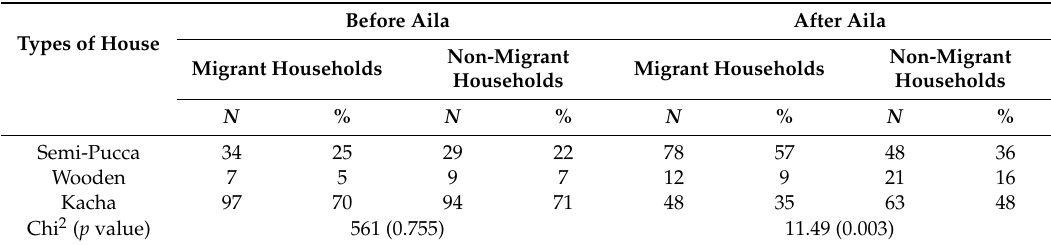
Table 12. Housing condition (before and after